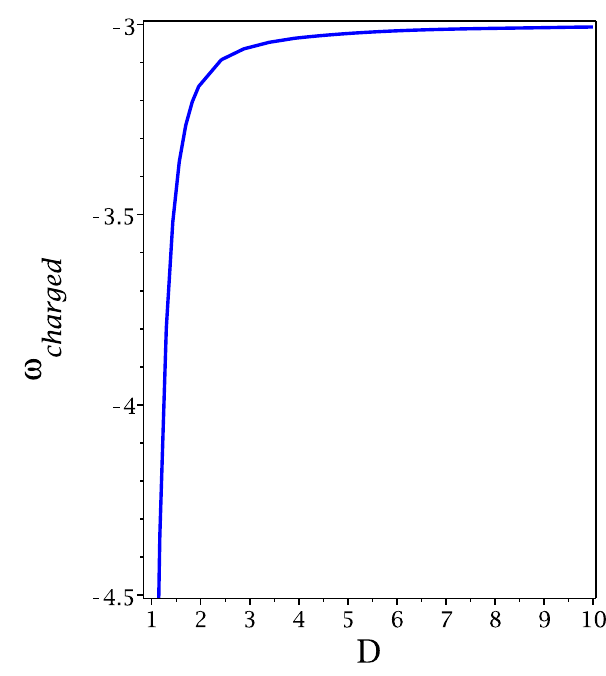
Fig. 15 ω charged vs radius D . We have chosen m 0 = − 4, L (ε) = 1 . 1, H (ε) = 1 . 1, σ 0 = 4, C 0 = 1, (cid:8)(ε) = − 1, m = 1, q = 1, and l =